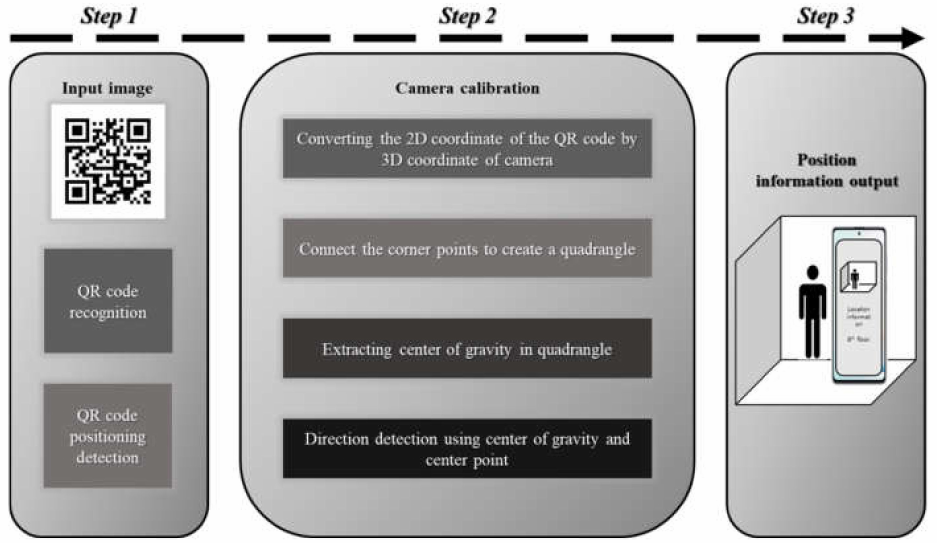
Figure 1. Flowchart of the proposed